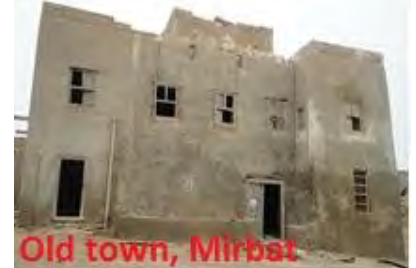
Figure 11. Fac¸ade’s photograph building location